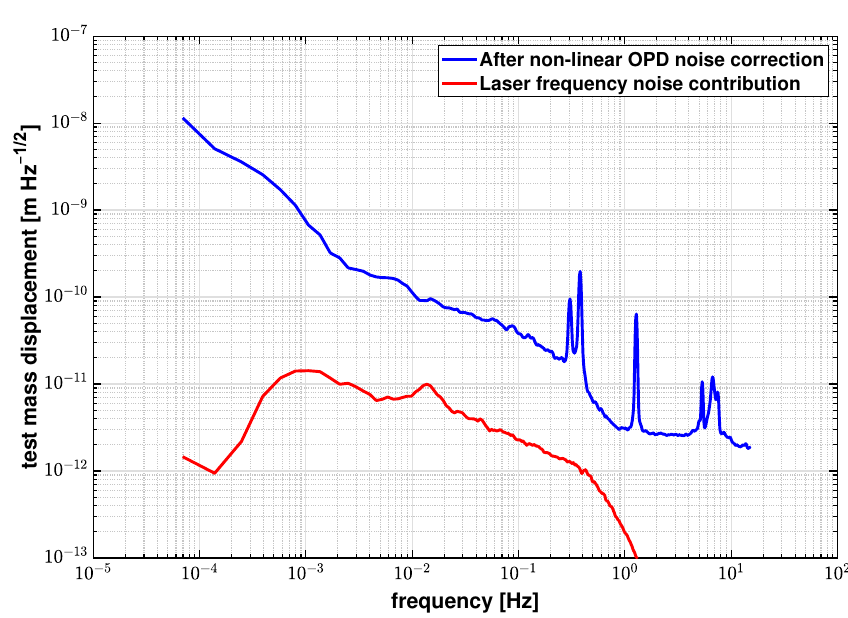
Figure 9. Laser frequency noise contribution estimated by a linear fit, compared to the OPD-noise- corrected differential measurement. The laser frequency noise is estimated to be 2.28 × 10 − 12 m/ at 100mHz, and is not the limiting noise source in our benchtop